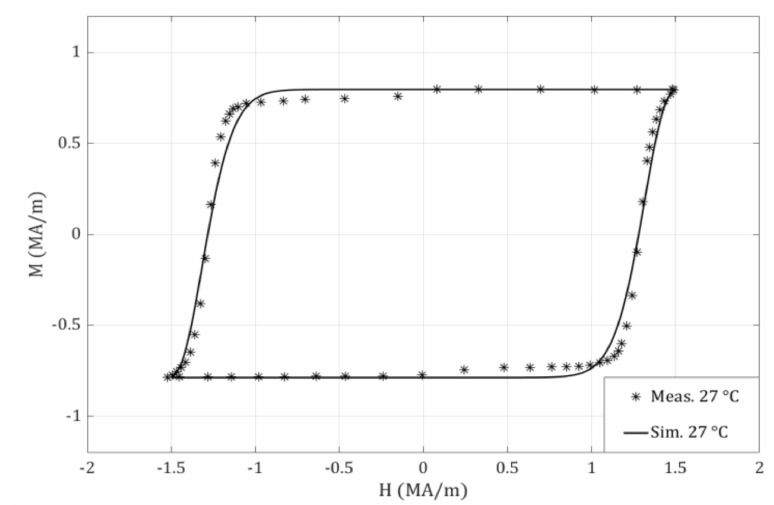
Figure 6. Hysteresis loop of a real NdFeB alloy sample measured at 27 ◦ C in